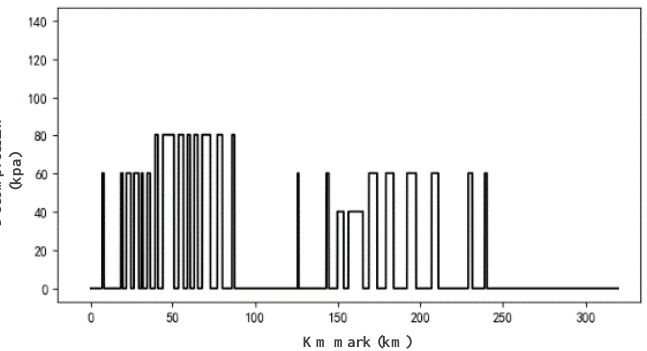
Figure 2. The air brake output by the expert